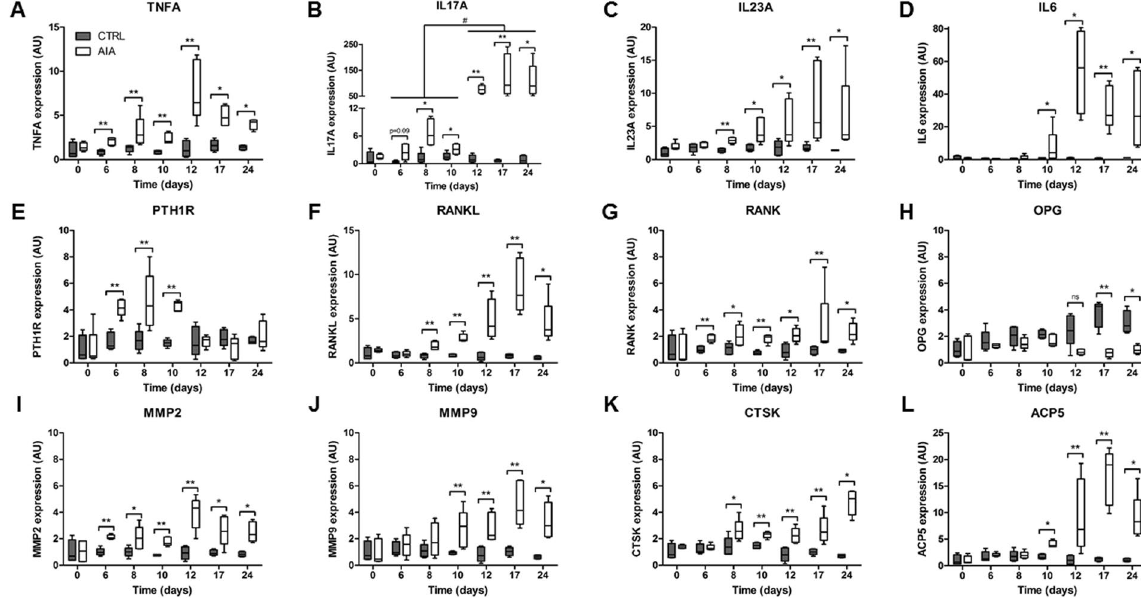
Figure 4. Early modifications in inflammation and resorption gene expression in the ankle. Quantitative RT-PCR was conducted at all 7 time points for evaluation of proinflammatory gene expression: ( A ) TNFA, ( B ) IL-17A, ( C ) IL-23A, and ( D ) IL-6. Expression of genes related to osteoclast activation pathway and matrix degradation function included ( E ) PTH1R, ( F ) RANKL, ( G ) RANK, ( H ) OPG, ( I ) MMP-2, ( J ) MMP-9, ( K ) CTSK, and ( L ) ACP5. Gene expression was normalized with housekeeping gene hypoxanthine- guanine phosphoribosyltransferase, and CTRL group expression at baseline was set at 1. Boxes and bars were median ± interquartile range. AU: arbitrary units; PTH1R: parathormone receptor 1; RANK: receptor activator of nuclear factor kappa B; RANKL: RANK ligand; OPG: osteoprotegerin; MMP: matrix metalloproteinase; CTSK: cathepsin K; ACP5: acid phosphatase 5, encoding the tartrate resistant acid phosphatase (TRAcP5). Kruskal-Wallis test in rat AIA group: # p < 0.05. Mann-Whitney test: * p < 0.05, ** p < 0.01, and *** p <